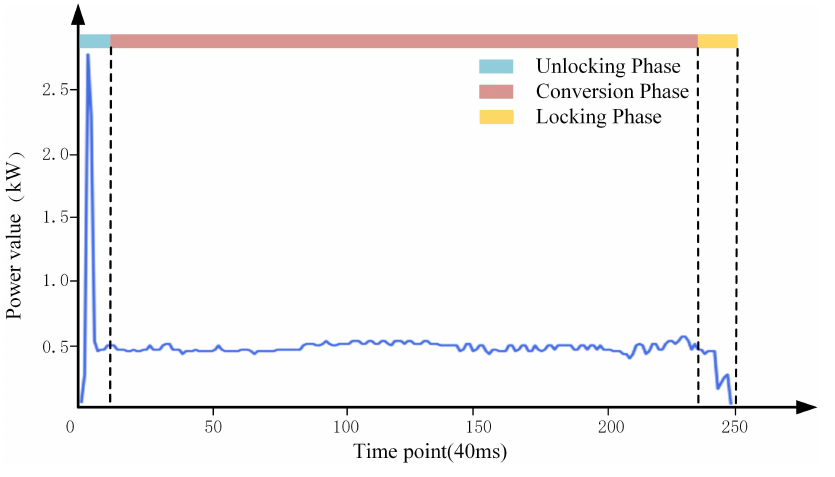
Figure 1. Turnout health power